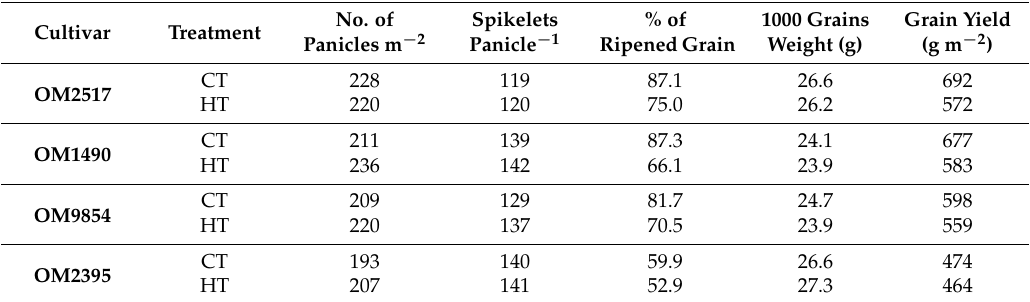
Table 3. Yields and yield components of 14 Vietnamese cultivars under control and high temperature treatments in